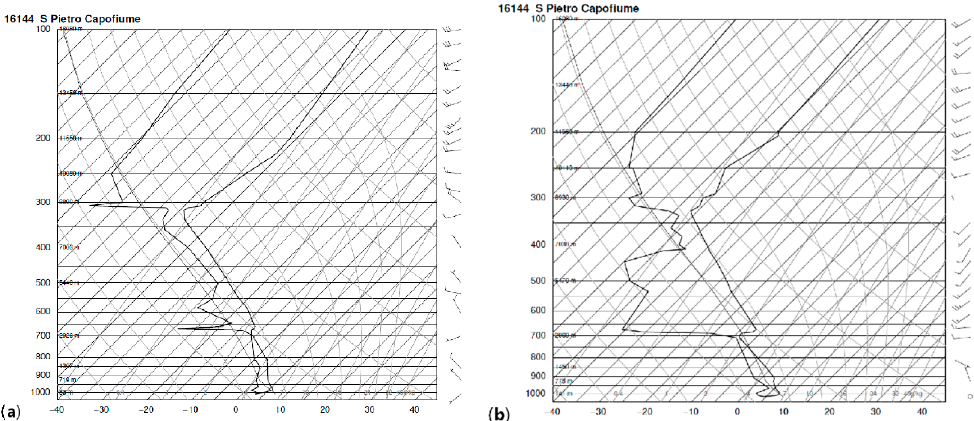
Figure A4. Atmospheric soundings on skew-T diagram obtained at the 0000 UTC of 8 ( a ) and 9 ( b ) February 2018 at San Pietro in Capofiume, 20 km north-north-east from Bologna. Within each plot, the leftish black line represents the dew point, the rightish black line is the temperature while the arrows are the wind speed in knots following the Beaufort scale (Source: http://weather.uwyo.edu/upperair/sounding.html).